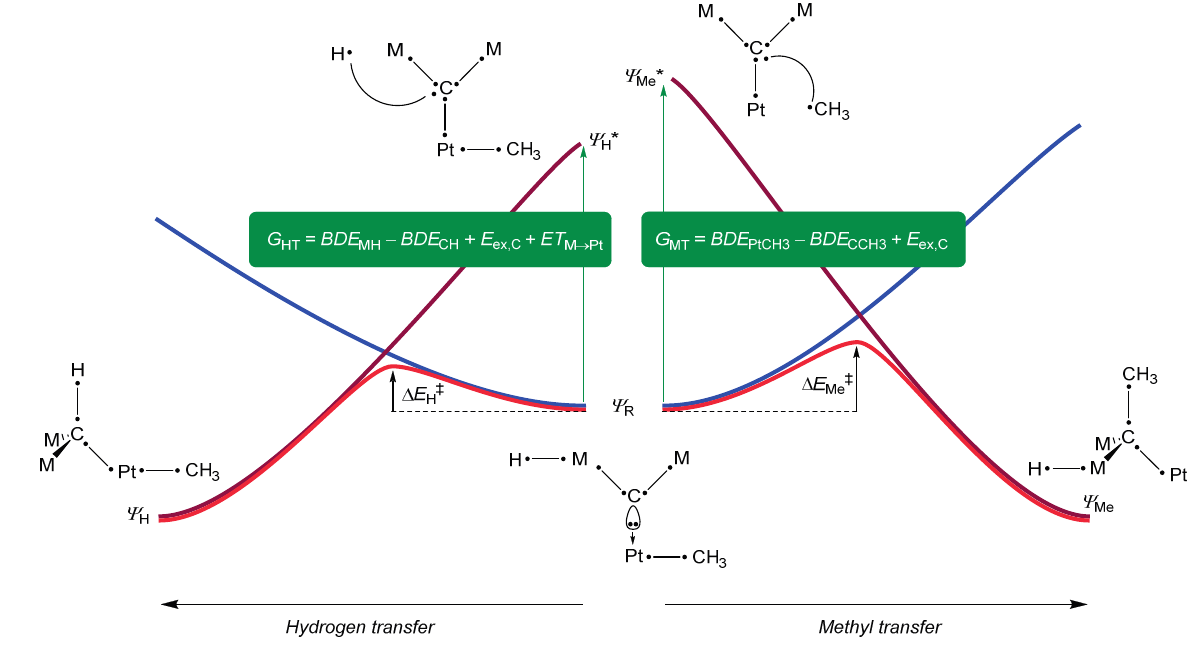
Figure 4. Valence bond curve crossing diagram that accounts for bond-breaking, bond-formation and electron-transfer processes in the transition states. Dots represents electrons and a line (curved or straight) represents a chemical